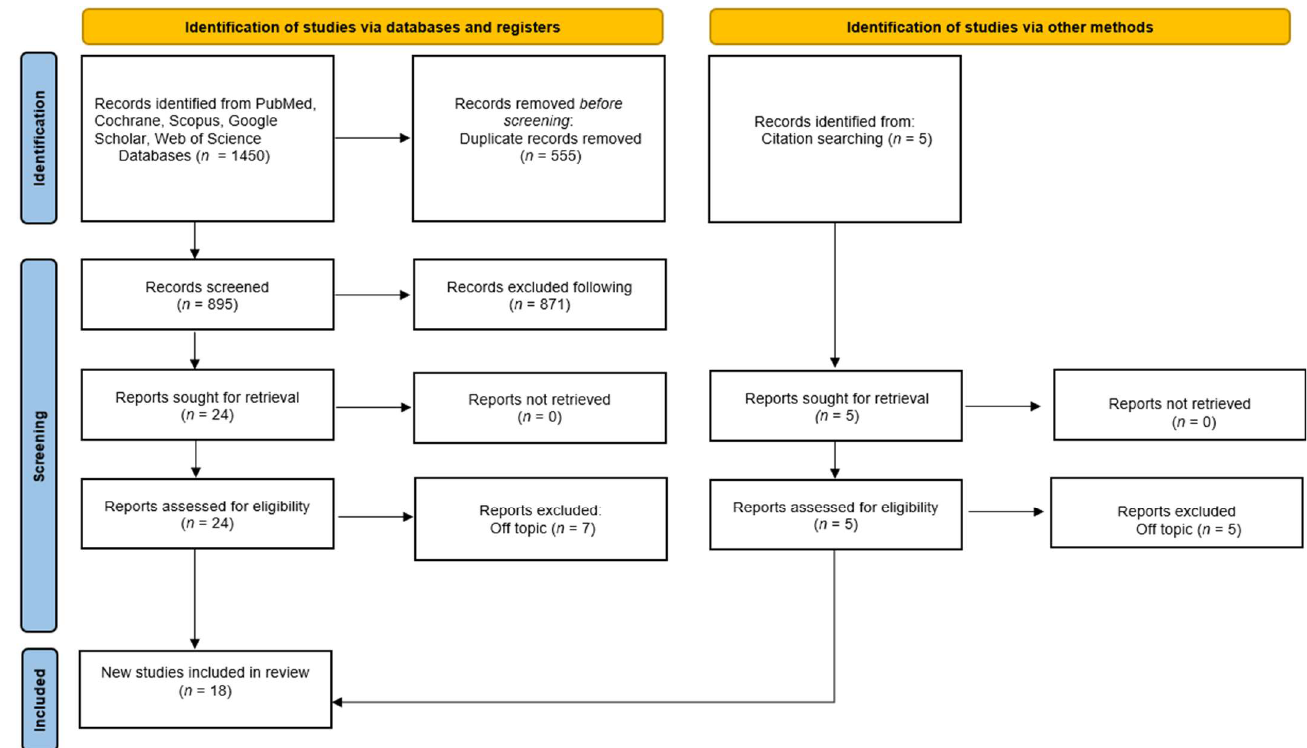
Figure 4. PRISMA flowchart diagram of the inclusion process [131].